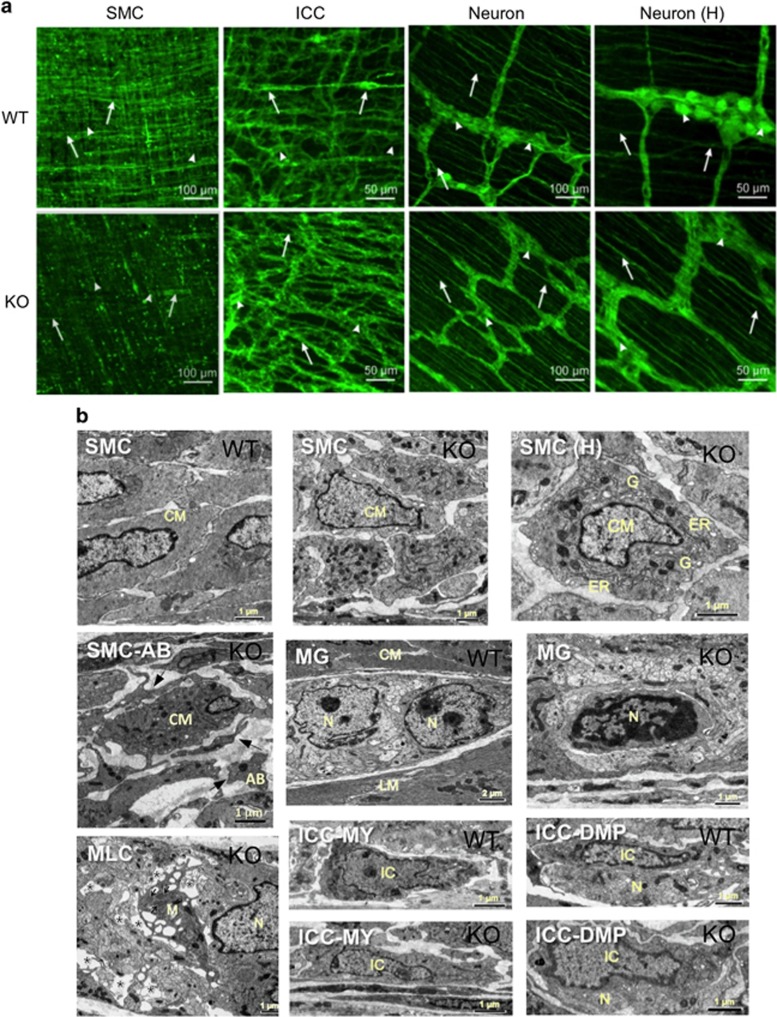
Cellular changes in Srf KO smooth muscle. Cellular changes in jejunal smooth muscle at PT21 were examined with cell marker antibodies using confocal or electron microscopy. (a) Whole-mount images showing phenotypic changes of KO SMCs compared with WT SMCs. SMCs were labeled with anti-MYH11 antibodies. Arrowheads and arrows indicate longitudinal and circular SMCs, respectively. Note structural defect in KO SMCs. Whole-mount images of ICC network. ICCs were labeled with anti-KIT antibodies. Arrowheads and arrows indicate ICC-MY and ICC-DMP, respectively. Whole-mount images of neuronal ganglia that were labeled with anti-PGP9.5 antibodies. Arrowheads and arrows indicate neuronal cells in ganglia and exons running in the muscle, respectively. High-magnification images (H) of neuronal cells are shown. Note significant neuronal cells were lost in KO ganglia. (b) Ultrastructural changes of KO and WT circular SMCs (CM). WT SMCs show normal ultrastructural features. The contour of KO SMCs is irregular and the extracellular space between the SMCs is wider than WT SMCs. A high magnification (H) of an irregular KO SMC is shown. A cellular fragmentation of a KO SMC surrounded by apoptotic bodies (SMC-AB: arrows). Ultrastructures of a MY ganglion (MG) containing neuronal cells (N) between the circular and longitudinal muscle layers in WT and KO muscle are shown. MLCs are observed within the ganglia. Arrows indicate lysosomes in the MLC (M). Asterisks show the damaged area within the ganglion. Ultrastructures of ICC-MY and ICC-DMP in WT and KO are shown. ICC-MY (IC) are located between circular and longitudinal smooth muscle layers and characterized by electron-dense cytoplasm and many mitochondria. ICC-DMP (IC) are closely associated with nerve bundles (N)